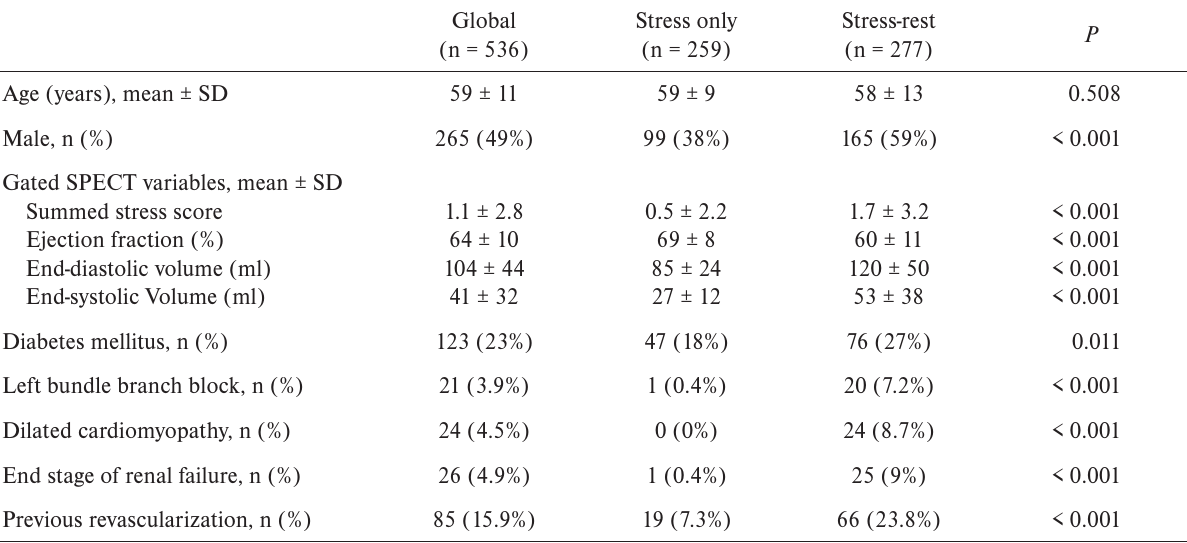
Table 1. Baseline clinical characteristics of patients with normal SPECT according to imaging